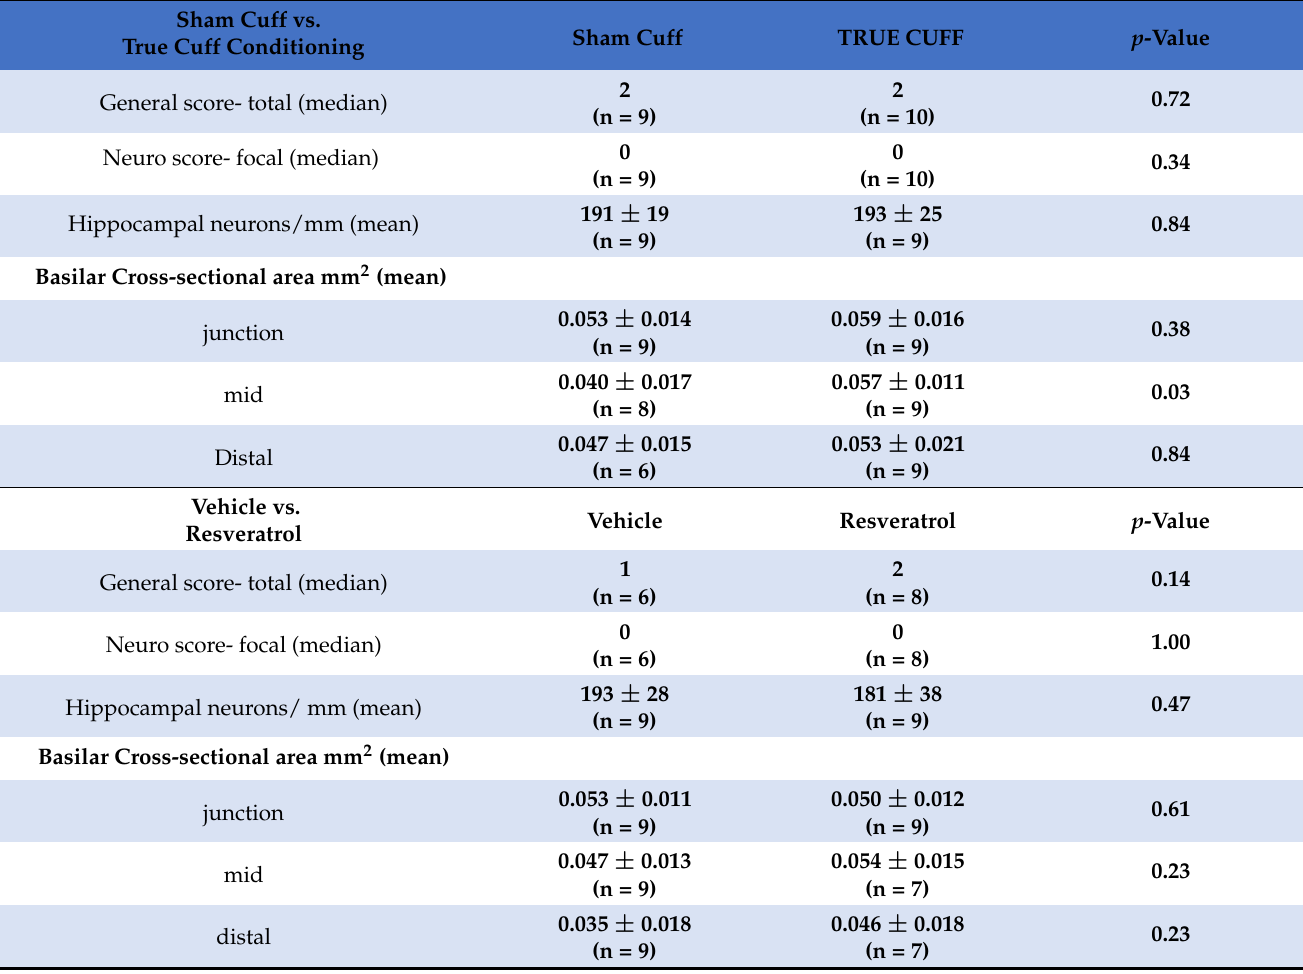
Table 1. Behavioral scores, histological data, and basilar artery cross-sectional area. Sham Cuff